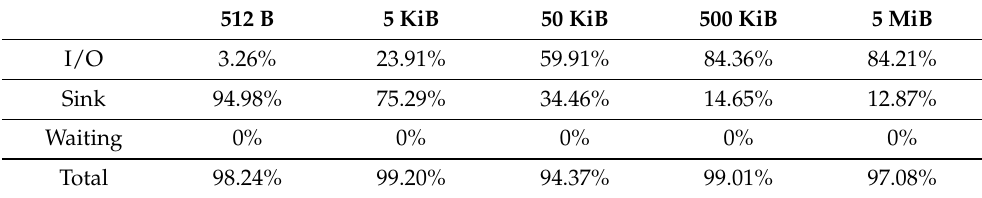
Table 1. Crypto Tile time divided in sections while performing SHA3-512.